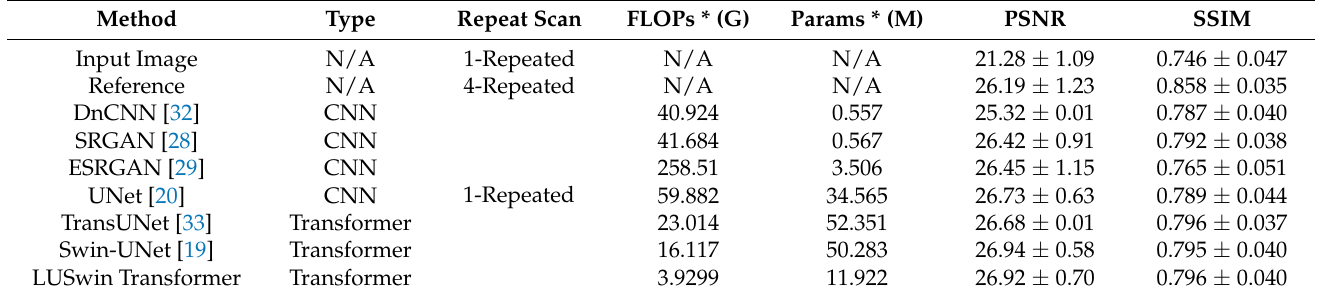
Table 3. Quantitative comparison (average ± standard deviation) with different